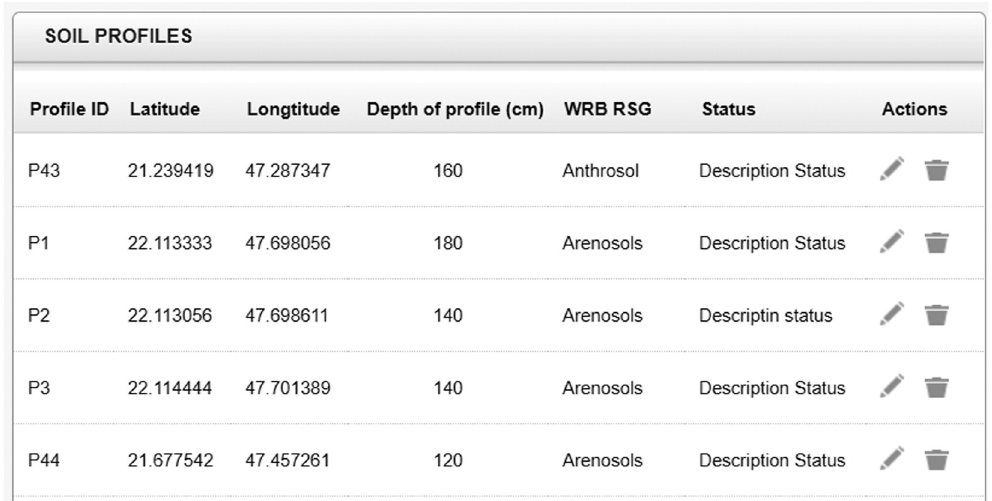
Figure 16: Interface of edit pro fi les